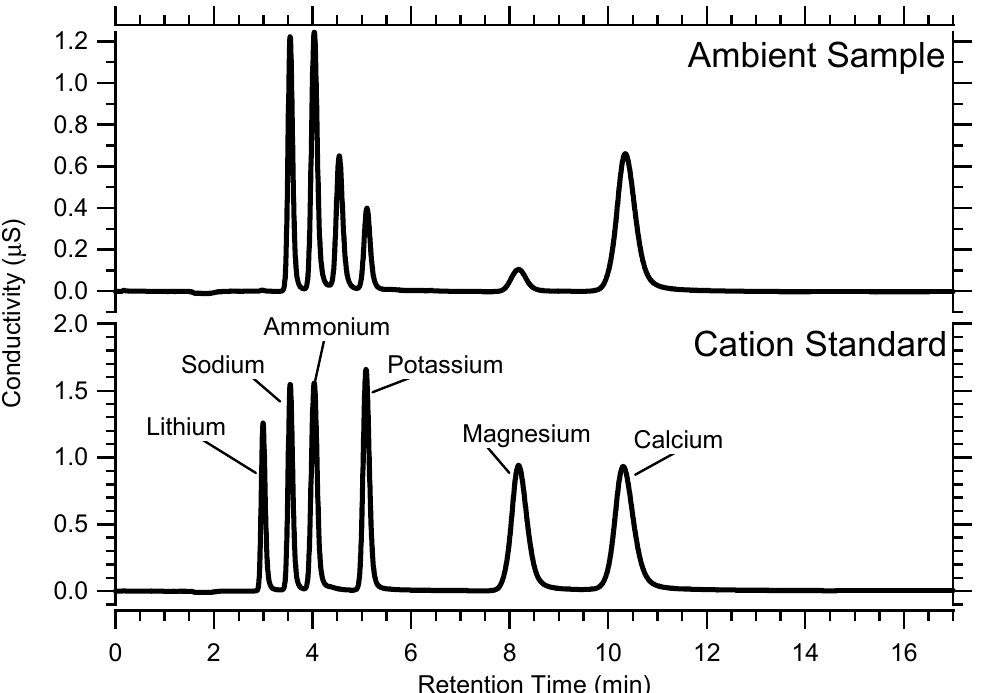
Figure 1. Chromatogram comparison of an ambient filter sample collected at the permanent monitoring station at Del Paso Manor in Sacramento County, CA on 7 November 2016 (top) and cation calibration standard (bottom). The separation was performed on a Thermo Scientific Dionex IonPac CS-12A (3 × 150 mm) column using an isocratic method with an eluent of 20 mM methanesulfonic acid at a flowrate of 0.5 mL min − 1 . The extra peak in the ambient sample at 4.5 min is likely due to amines.